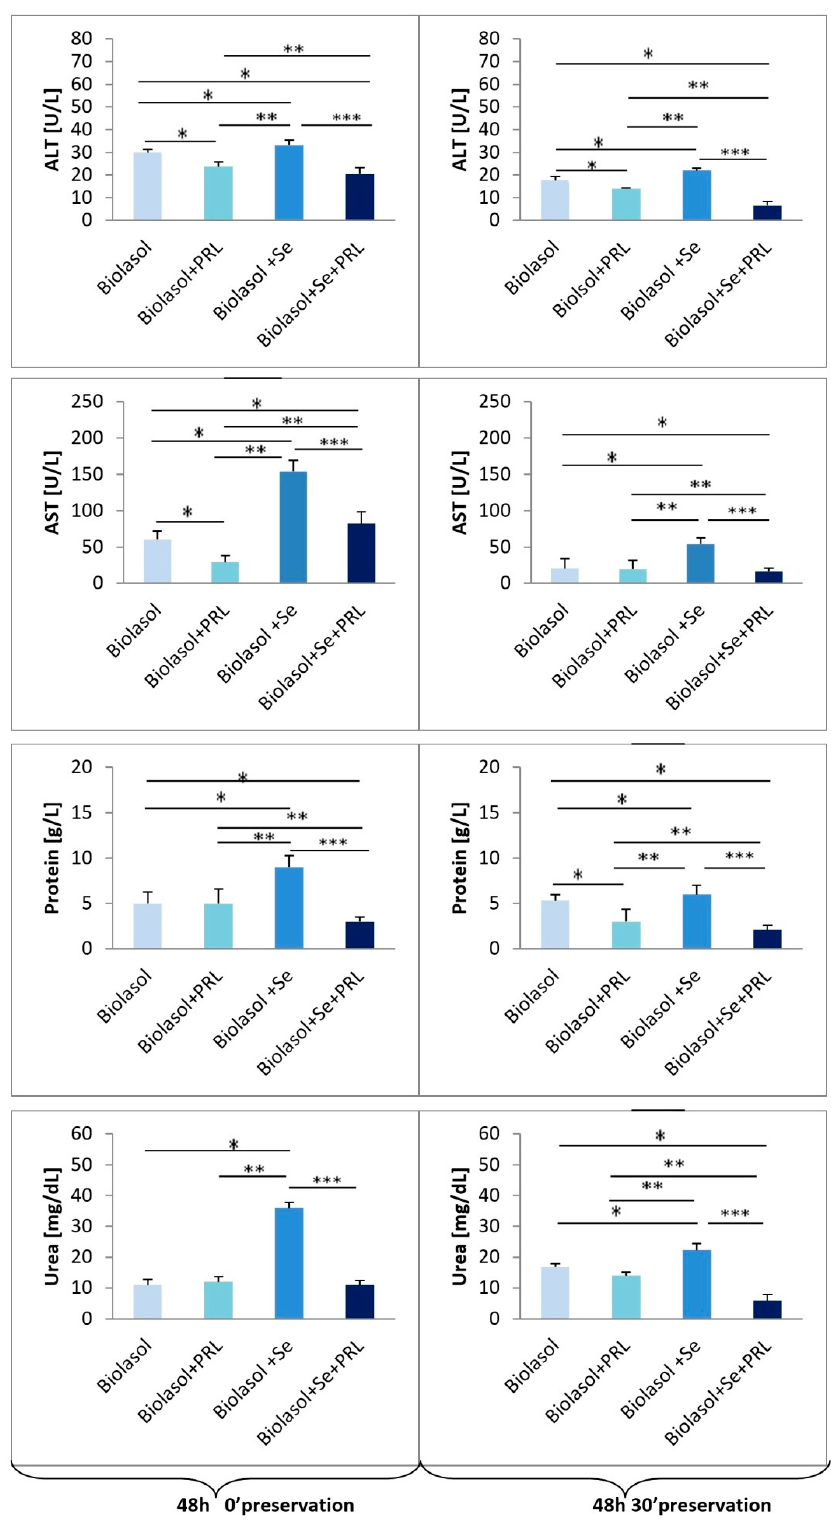
Figure 3. The effect of selenium on ALT, AST, protein, urea levels in porcine kidneys (48 h 0 ′ and 48 h 30 ′ preservation). Means ± standard deviations (SD) are shown. The symbols represent a significant difference ( p < 0.05) compared with the Biolasol ® group (*), the Biolasol ® +PRL group (**), and the Biolasol ® +Se group (***).